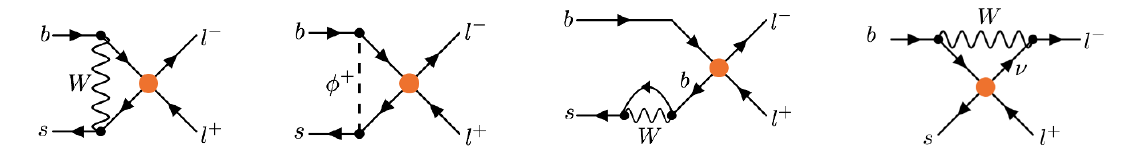
Figure 3 . Diagrams generating contributions to b ! sl + l (cid:0) from Q eu and Q lu ((cid:12)rst two diagrams only), Q (1) and Q qe ((cid:12)rst three diagrams and similar) and Q (3) lq